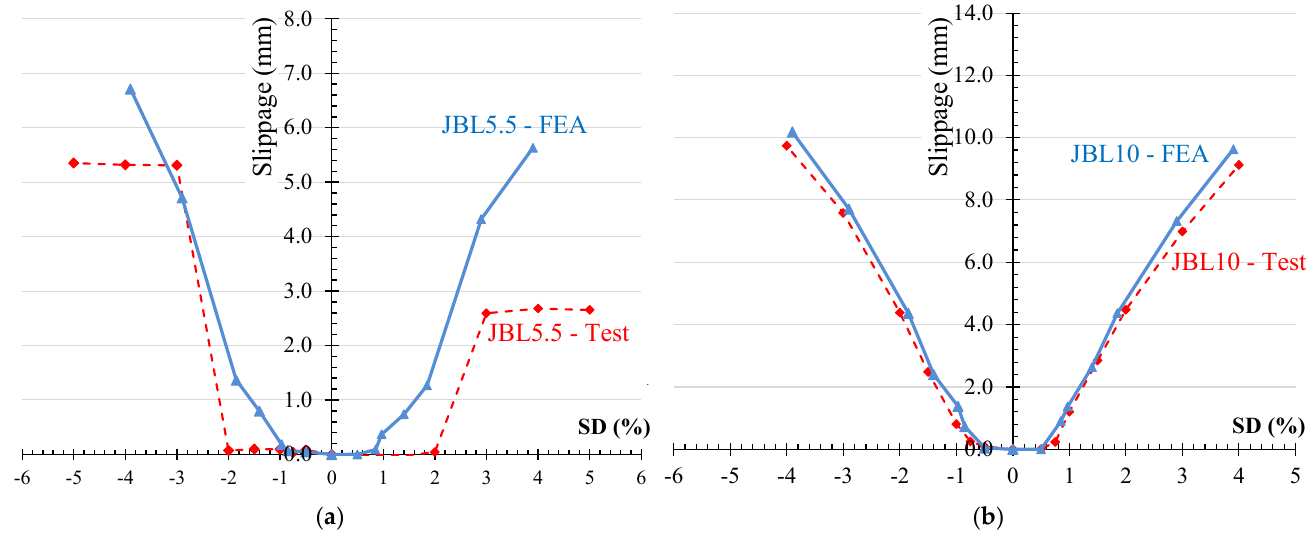
Figure 13. Verification of slip prediction of FE model in terms of slippage versus SD diagrams of the corresponding specimens: ( a ) JBL5.5—Test, JBL5.5—FEA and ( b ) JBL10—Test, JBL10—FEA.